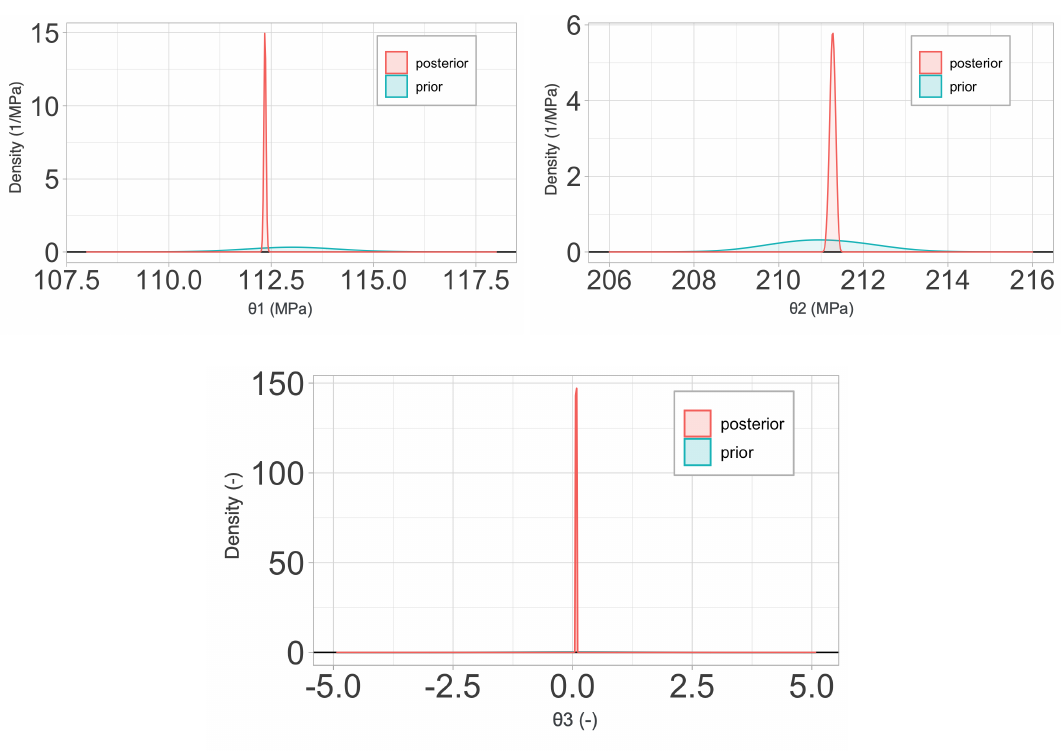
Figure 14. Prior vs. posterior probability distribution functions of parameters A ∼ θ 1 , B ∼ θ 2 , C ∼ θ 3 , in the JC model considering ∆ L as the QoI.